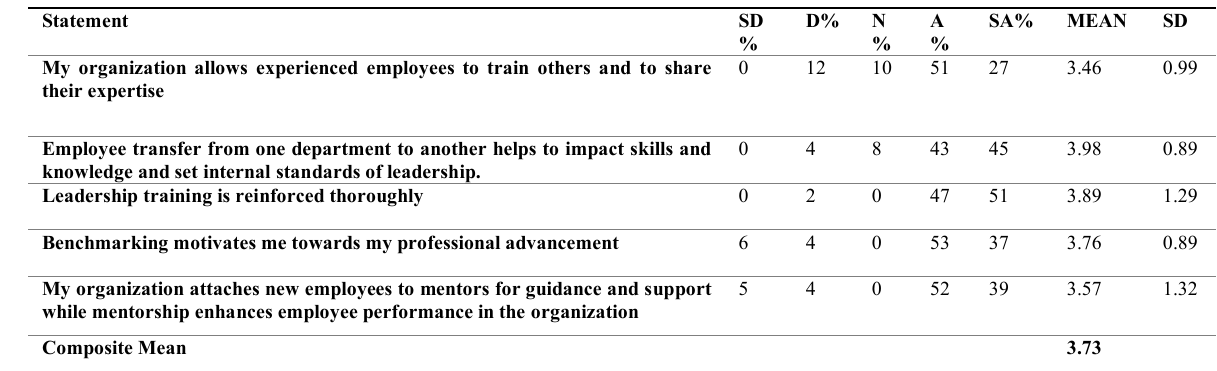
Table 1: Leadership Skills in the